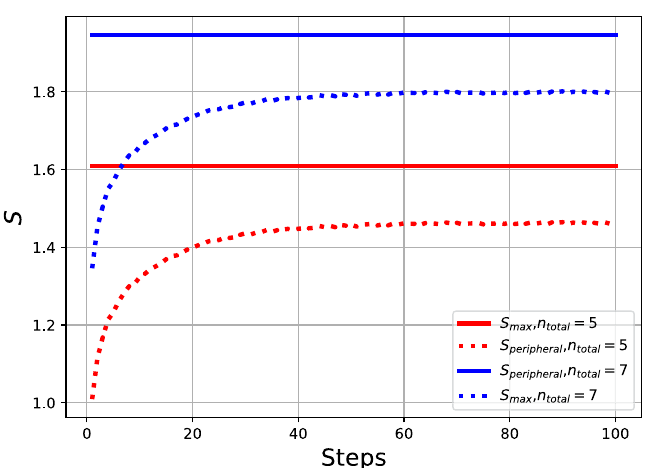
Figure 5. The figure displays the peripheral and maximum entropies of the system when n total = 5 (red) and n total = 7 (blue) respectively. The solid lines are the total entropies of the system S max and the dotted lines S peripheral . Higher values arise with the increases of the total amount of actions of the agents per time